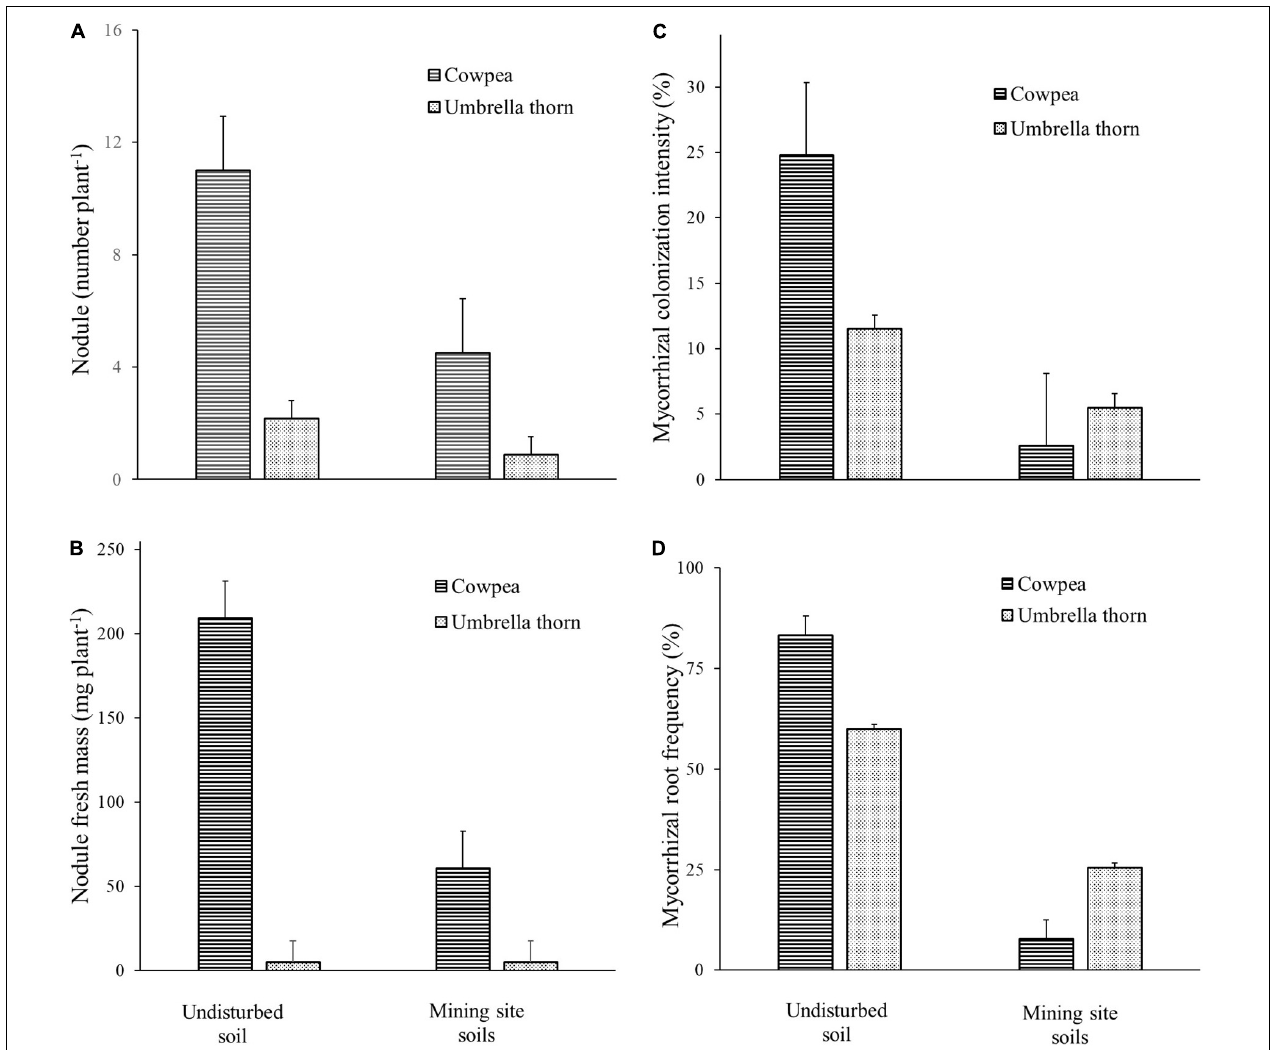
FIGURE 5 | Nodulation (A,B) and mycorrhizal colonization of roots (C,D) of umbrella thorn and cowpea grown in contrasting greenhouse soil types: (A) number of nodules; (B) nodule fresh mass; (C) intensity and (D) frequency of mycorrhization in natural undisturbed soil (NS) compared to soils at the mine site. Error bars represent the standard errors of